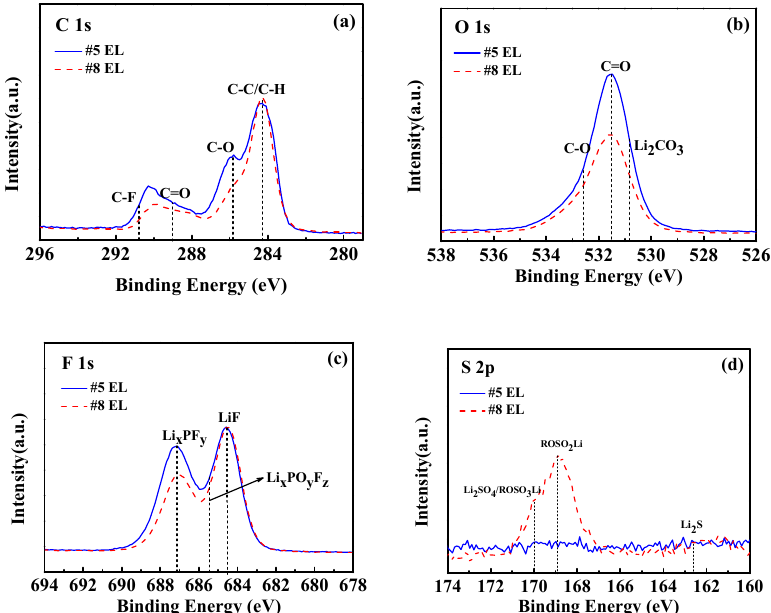
Figure 16. XPS spectra of the graphite anodes cycled in the electrolytes without DDDT additive and in 2 wt.% DDDT after 150 cycles at 45 °C: (a) C 1s; (b) O 1s; (c) F 1s; (d) S 2p.